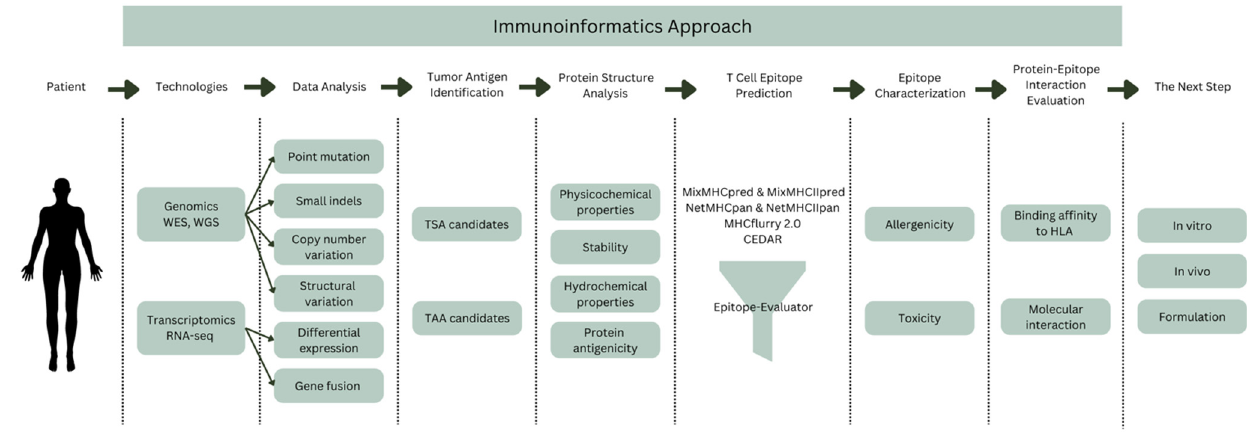
Figure 1. Overview of immunoinformatics approach in cancer vaccine development. Tumor antigens can be identified using high-throughput technologies such as WES, WGS, and RNA-seq. Immunoinformatics can help in protein structure analysis, T cell epitope prediction, epitope characterization, and protein–epitope interaction evaluation. WES—whole exome sequencing; WGS—whole genome sequencing; TSA—tumor-specific antigen, TAA—tumor-associated antigen,